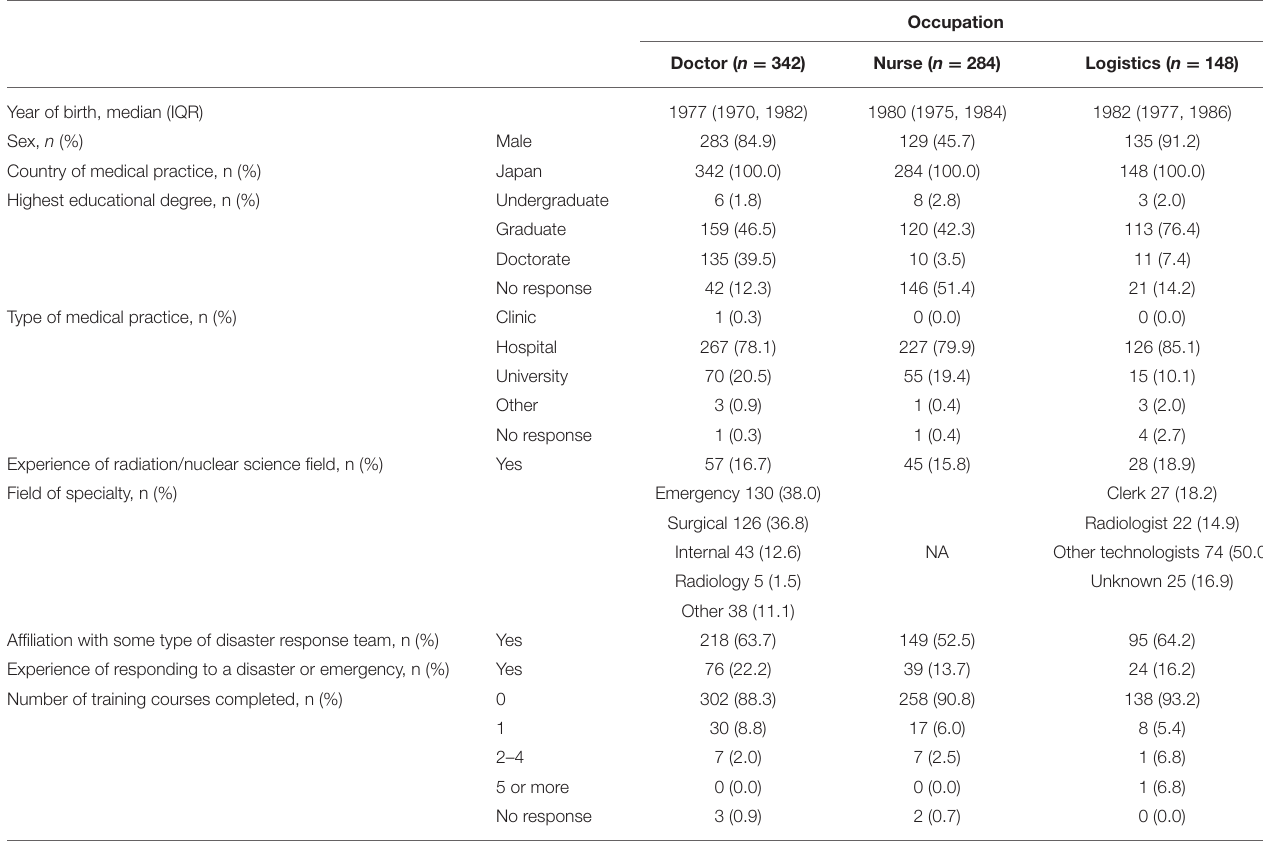
TABLE 1 | Respondents’ demographic and background